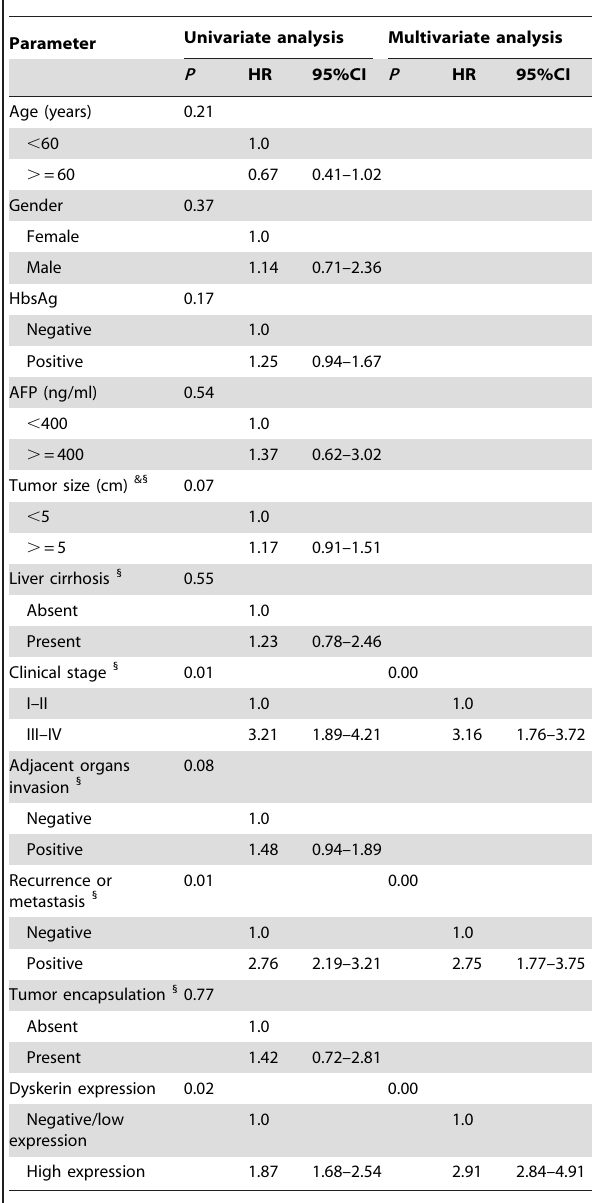
Table 2. Univariate and multivariate analyses of different prognostic factors with overall survival in 252 patients with HCC (Cox Proportional Hazards